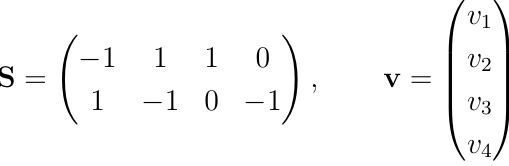
and v have the 1 2